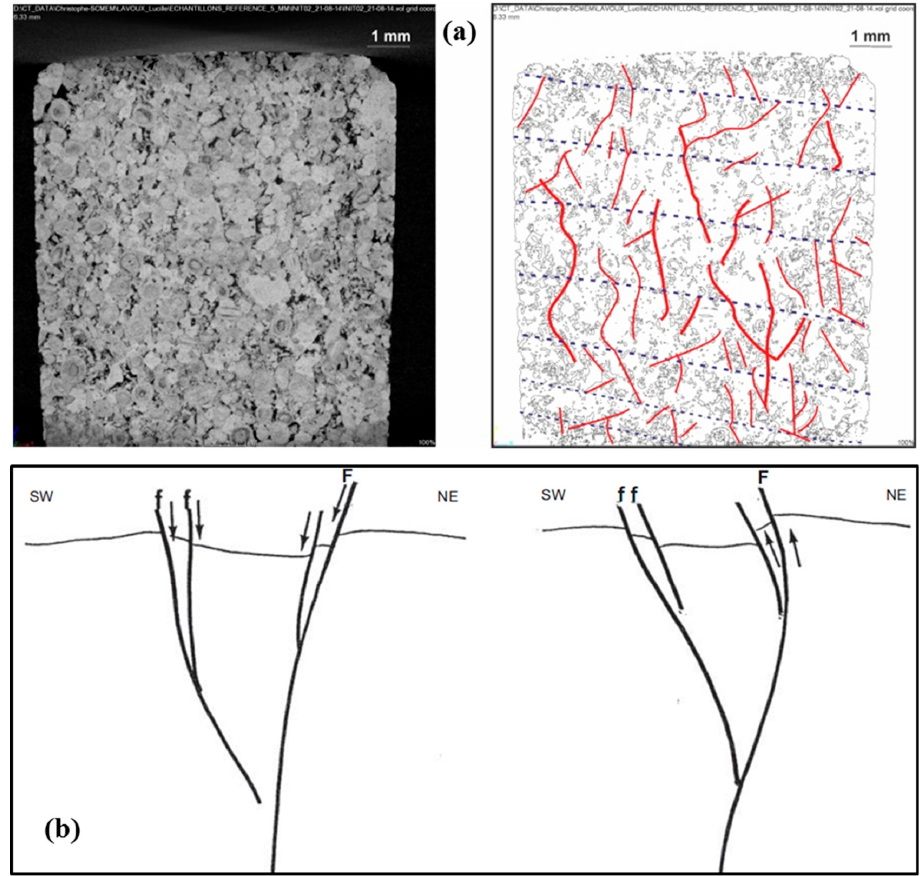
Figure 4. ( a ) CT scans of samples of Lavoux limestone in the vertical section with delineation within at the microscale-level microlayer boundaries (dashed blue lines) and upward splaying shear microfaults (red lines); ( b ) structural data of the Saint-Maixent-l’École graben [30]; this segment of the Southern Armorican Shear Zone is located ~80 km southwest of Chauvigny. The major faults “F” inherited the Variscan basement faults and complimentary sedimentary carapace’s antithetic faults “f” tend to join downward into single strands, forming a specific pattern of flower structures as a typical marker of lateral movements associated with strike-slip zones. Note, this structural interpretation of the regional tectonic structure of the study area ( b ) is compatible with our results of microfaults’ matrix interpretation ( a ). Note also for ( b ) the regional scale (several tens of km) to be compared with the centimetric scale in ( a